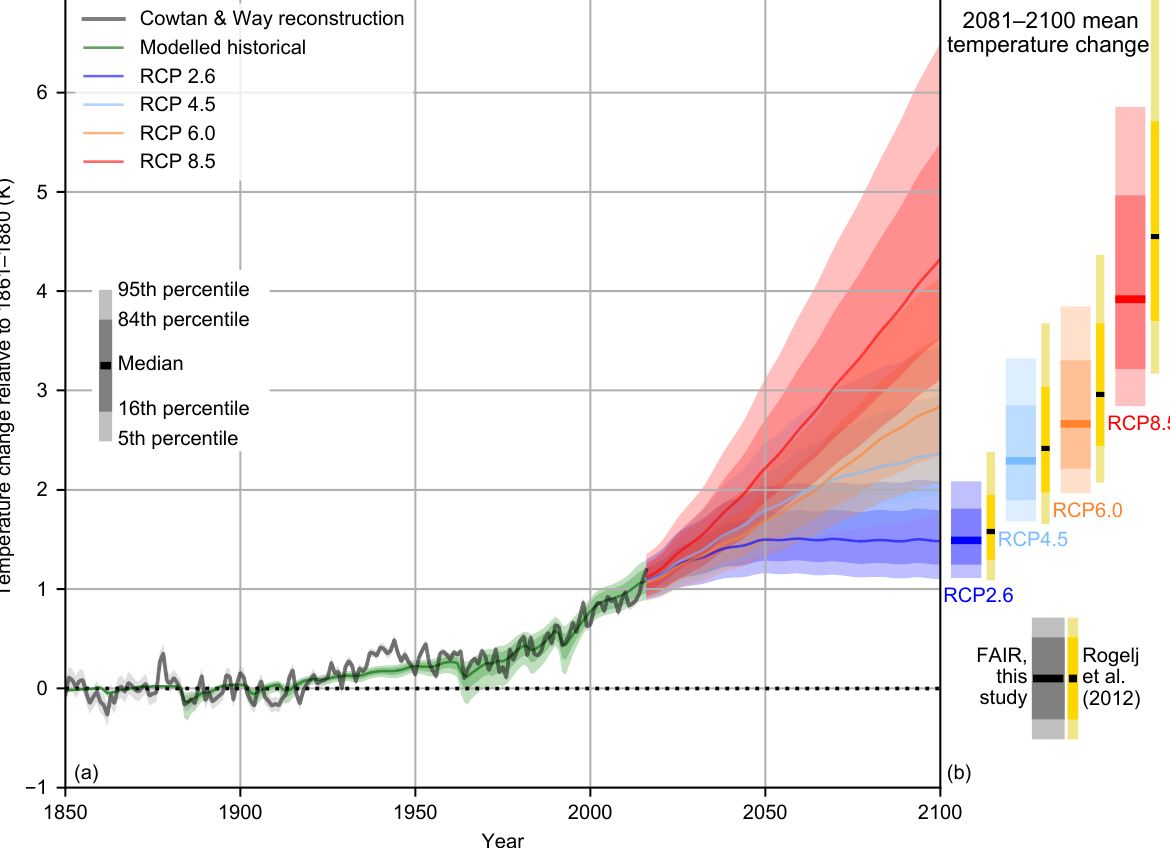
Figure 8. (a) Historical constrained modelled temperature and future probabilistic temperature scenarios from FAIR driven by emissions and forcing from the RCPs for 1850–2100 expressed as temperature change since 1861–1880. Also shown is observed temperature from C&W. (b) Comparison of 2081–2100 mean temperature from FAIR compared to the emission-driven ensemble from MAGICC6 (Rogelj et al.,